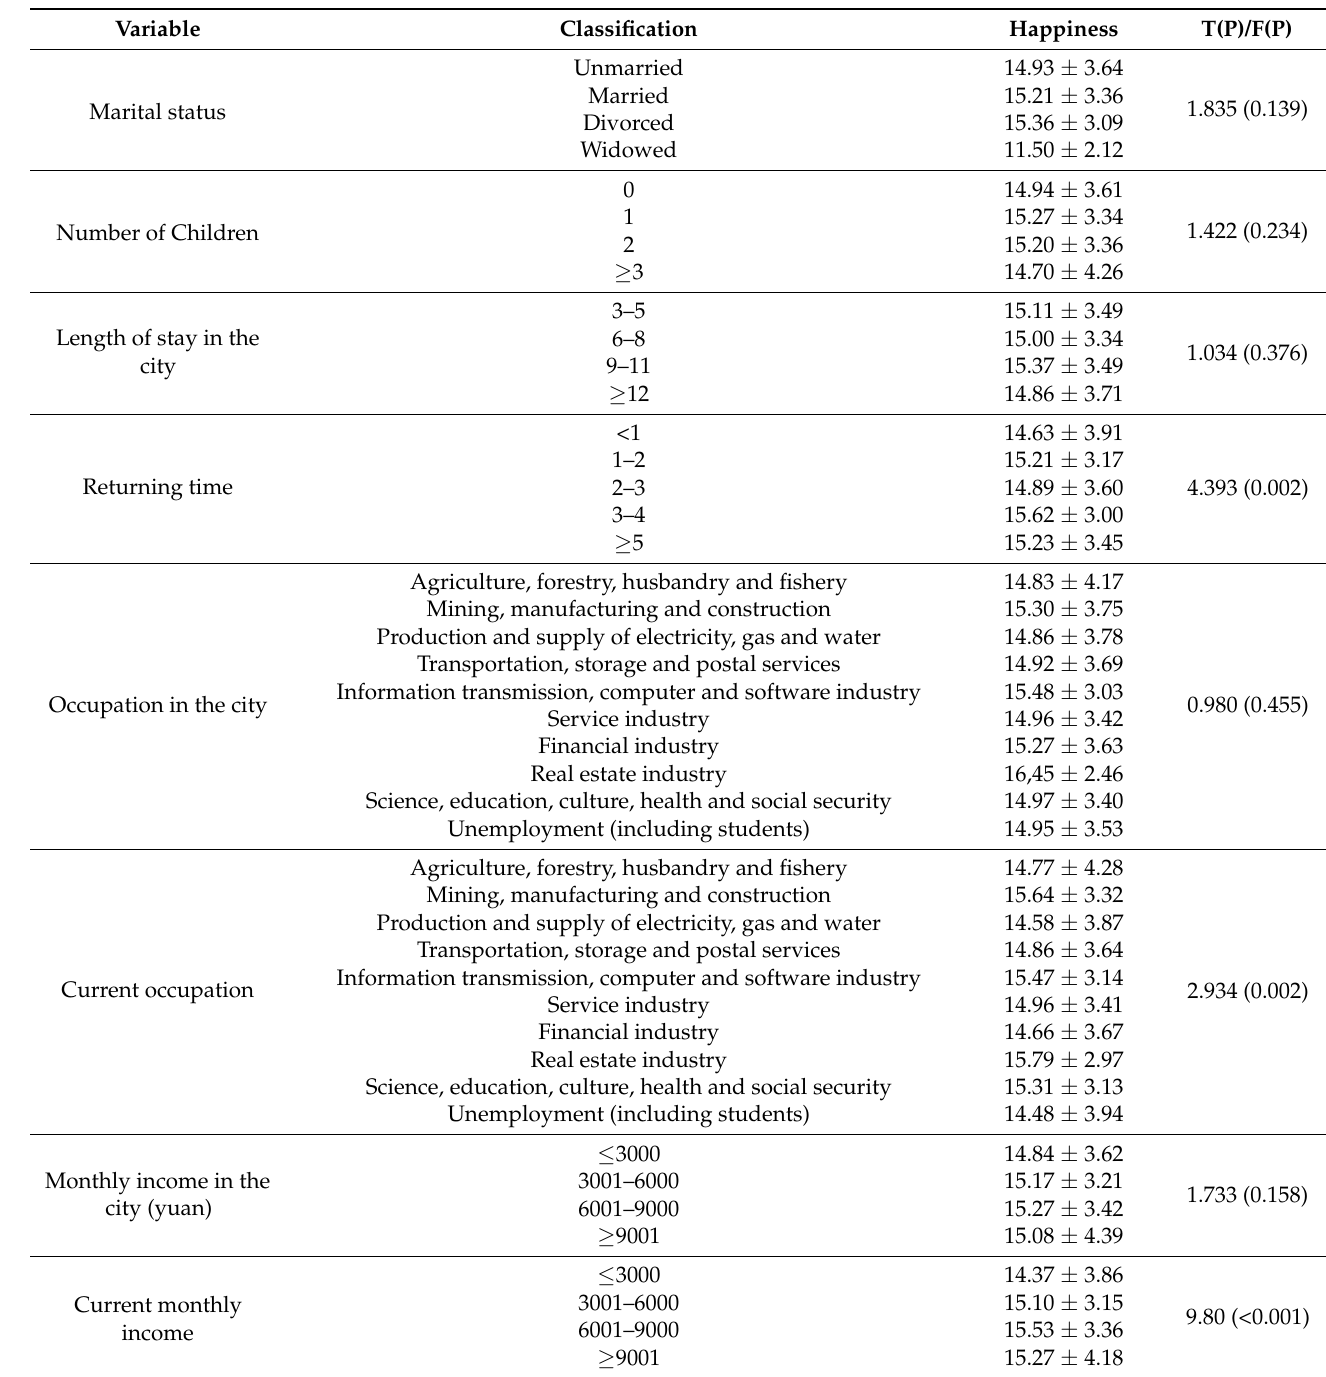
Table 4 indicates that all independent variables are positively associated with urban young returnees’ happiness, and the correlation coefficients are more than 0.6. This shows that the variables we selected are suitable for the next